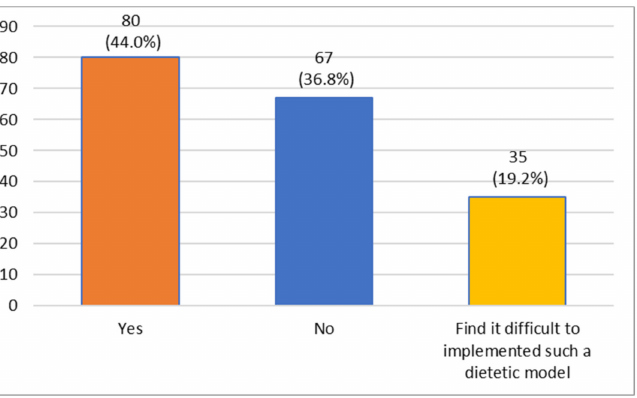
Figure 1. Distribution of the answers given by children regarding healthy